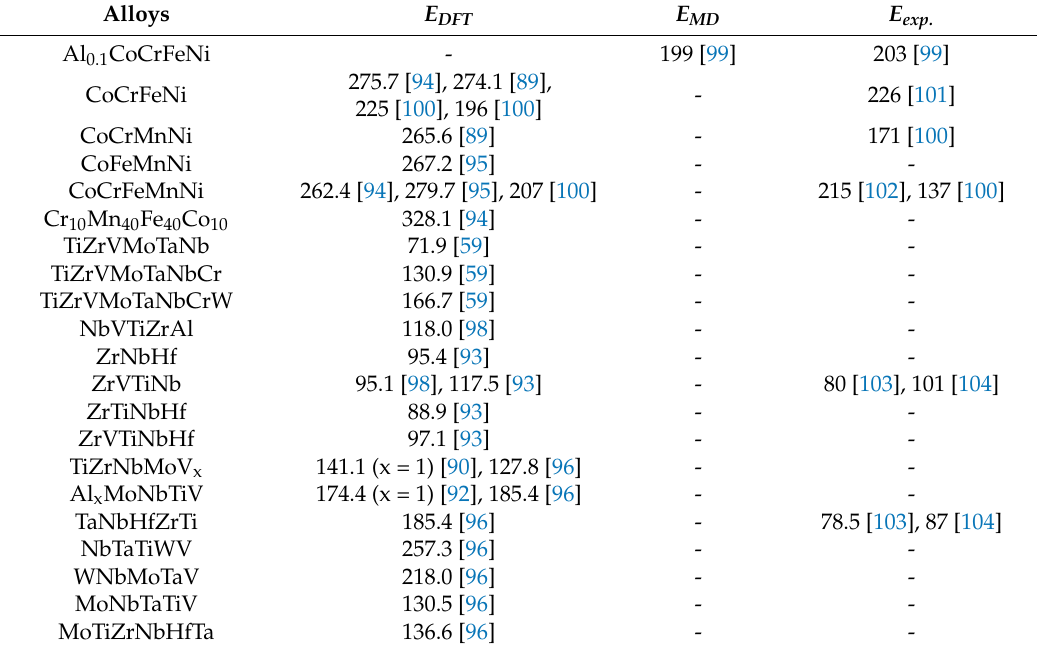
Table 1. Available Young’s moduli (GPa) of MPE alloys in literature. Alloys E DFT E MD E